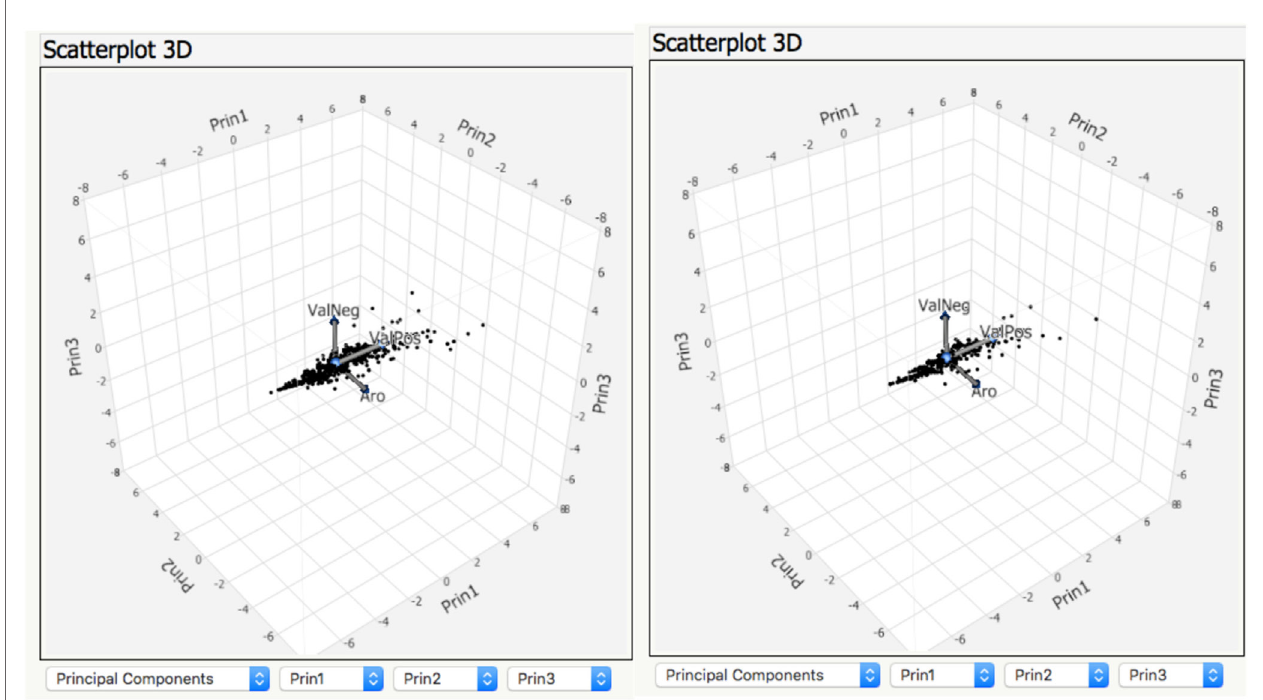
FigUre 4 | 3D scatterplot for the principal components extracted from the valence and arousal values of the words in George Eliot’s poem “How Lisa Loved the King” (left panel) and James Joyce’s “Chamber Music” (right